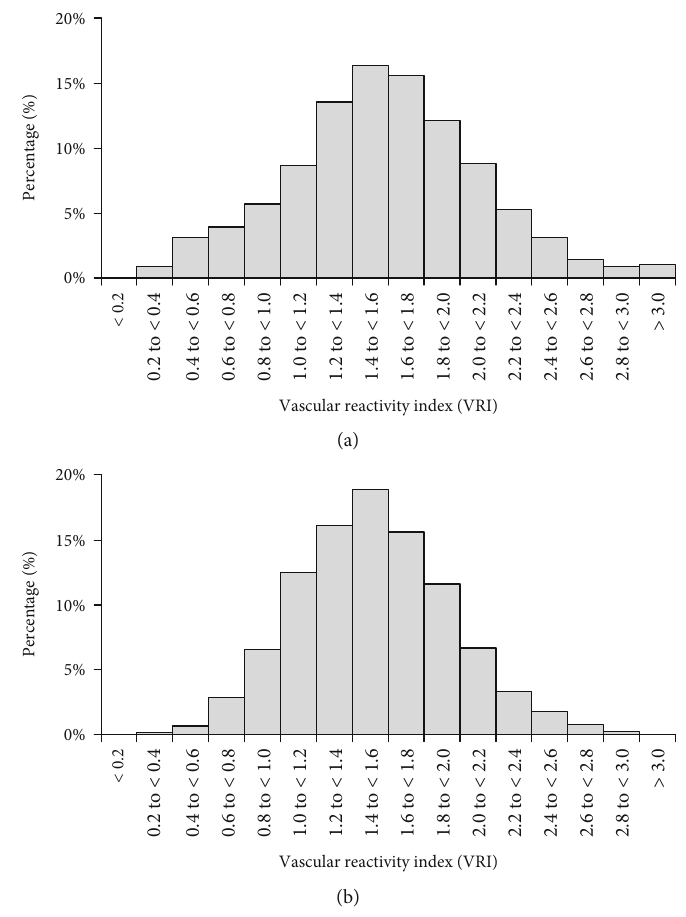
Figure 3: Distributions of vascular reactivity index (VRI) in Registry-I (a) and in Registry-II (b).